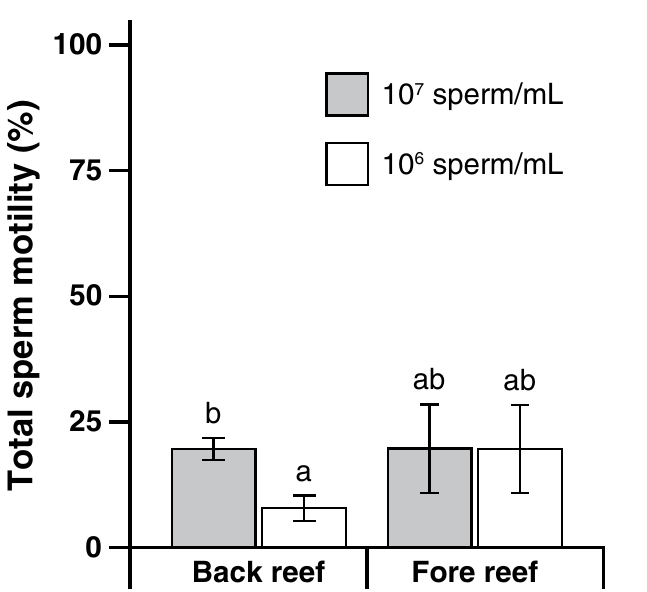
Figure 3. Total sperm motility was assessed with a phase microscope in samples from Acropora hyacinthus colonies collected from back and fore reef areas in Moorea, French Polynesia, diluted to concentrations of 10 6 and 10 7 cells/mL. Data are presented as mean ± SE and columns with the same letter are not significantly different ( P <